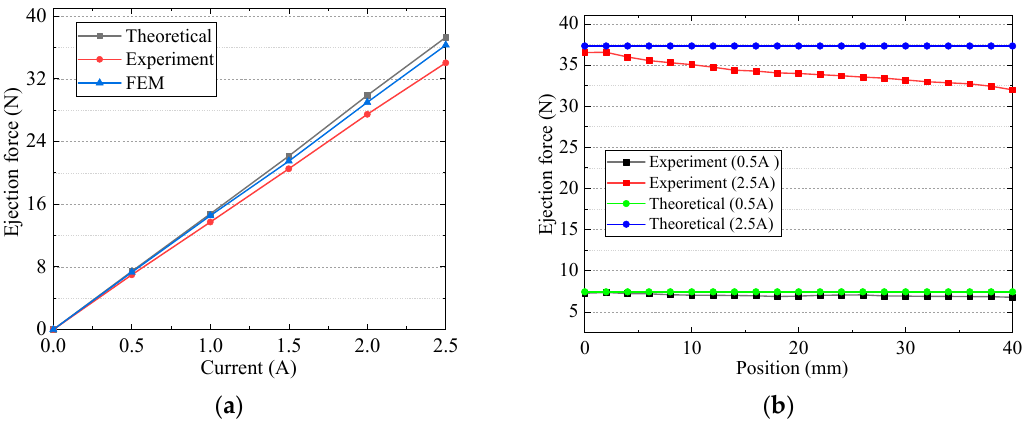
( b ) Figure 18. Measurement of electromagnetic force: ( a ) ejection force of the launcher; ( b ) attractive force and driving force of the conveying platform. The measurement results of ejection force are shown in Figure 19. The theoretical results agree well with the experimental results, meaning that the electromagnetic force model obtained from the equivalent magnetic circuit method is reliable. With the en- hancement of the current for high ejection force, the error between the theoretical results and experimental results increases. The reason is that the armature field produced by